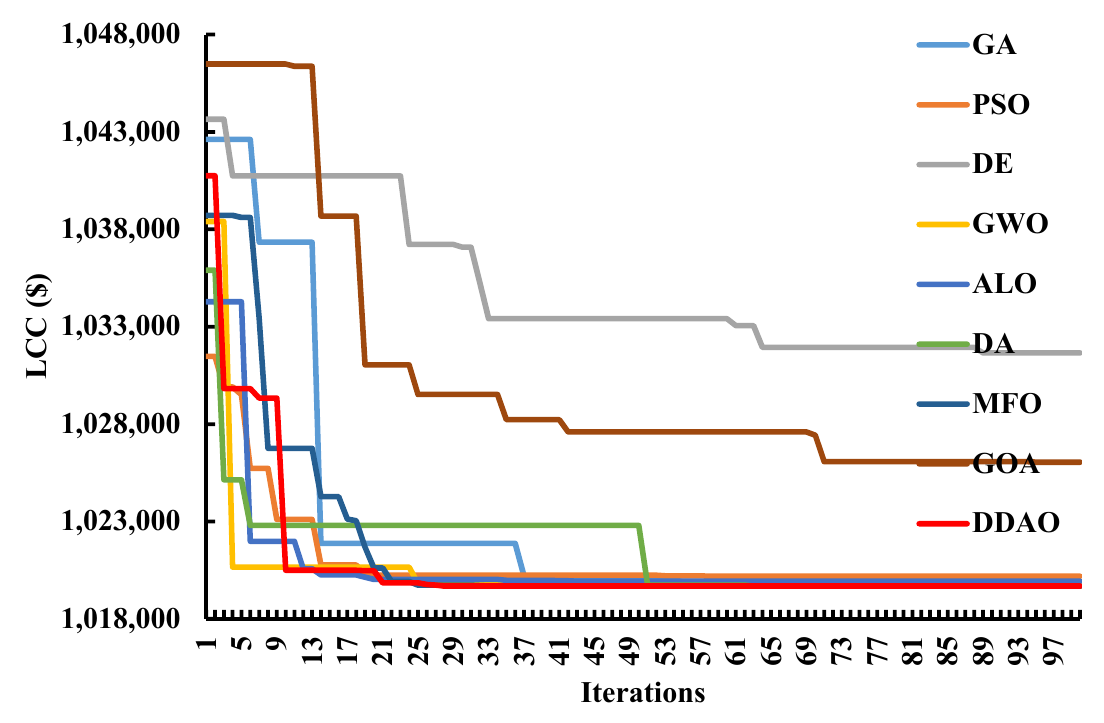
Figure 11. Convergence curves of the configuration made up of Li-Ion battery.